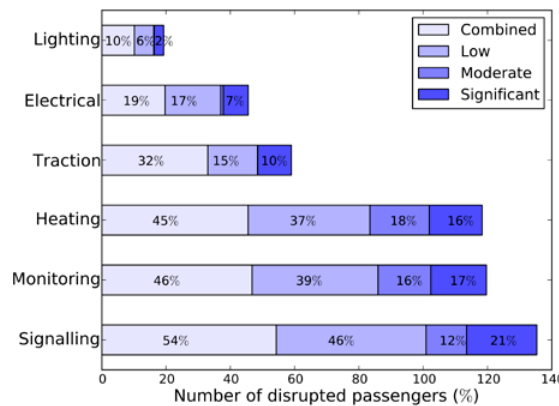
Figure 10. Flood vulnerability result showing the percentages of different types within each flood likelihood zone.